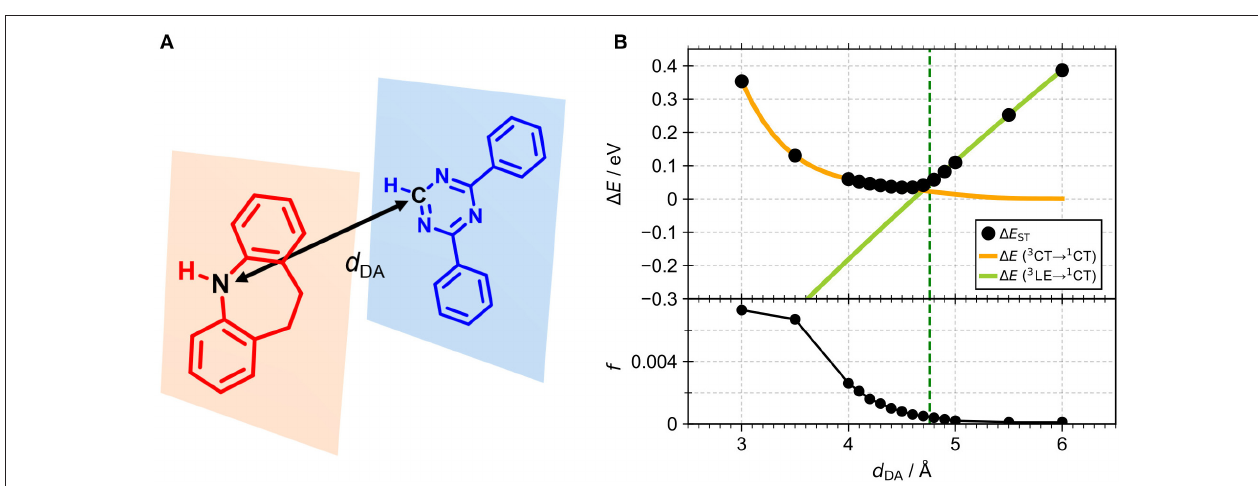
FIGURE 3 | (A) The structures of the IB donor and T acceptor. (B) Calculated energy differences, 1 E ST , 1 E ( 3 CT → 1 CT) and 1 E ( 3 LE → 1 CT) (top) and f -values (bottom) as a function of d DA for the combination of IB and T. Green dashed line indicates d DA of TpIBT-tFFO (4.76 Å).